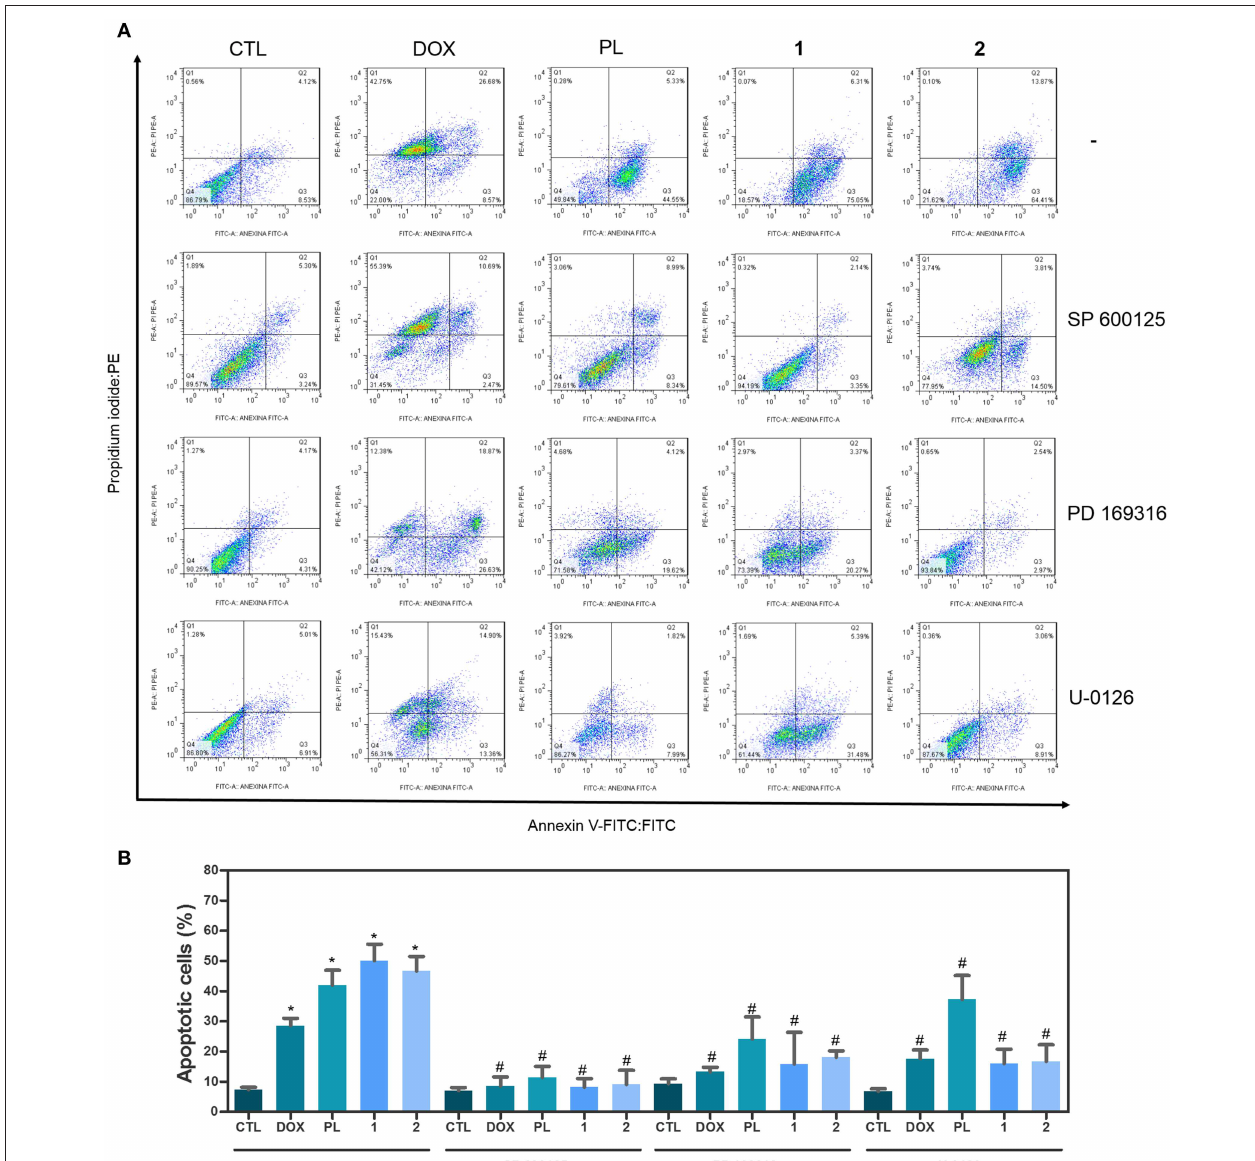
FIGURE 2 | Effect of JNK/SAPK inhibitor (SP 600125), p38 MAPK inhibitor (PD 169316), and MEK inhibitor (U-0126) in the apoptosis induced by ruthenium complexes with piplartine in HCT116 cells, as determined by flow cytometry using Annexin V-FITC/PI staining. (A) Representative flow cytometry dot plots showing percentage of cells in viable (annexin V-FITC negative and PI negative cells), early apoptotic (annexin V-FITC positive, but PI negative cells), late apoptotic (annexin V-FITC positive and PI positive cells), and necrotic stages (PI positive, but annexin V-FITC negative cells). (B) Quantification of apoptotic HCT116 cells (annexin V-FITC positive cells). For protection assays, cells were pretreated for 2h with 5 µ M SP 600125, 5 µ M PD 169316„ or 5 µ M U-0126, and then incubated with ruthenium complexes at established concentration (2.5 µ M for complex 1 and 5 µ M for complex 2 ) for 48h. Negative control was treated with the vehicle (0.1% of a solution containing 70% sorbitol, 25% tween 80 and 5% water) used for diluting the complexes tested. Doxorubicin (1 µ M) and piplartine (10 µ M) were used as the positive controls. Data are presented as mean ± S.E.M. of at least three independent experiments performed in duplicate. Ten thousand events were evaluated per experiment, and cellular debris was omitted from the analysis. * P < 0.05 compared with negative control by ANOVA, followed by Student-Newman-Keuls test. # P < 0.05 compared with respective treatment without inhibitor by ANOVA, followed by Student-Newman-Keuls test.